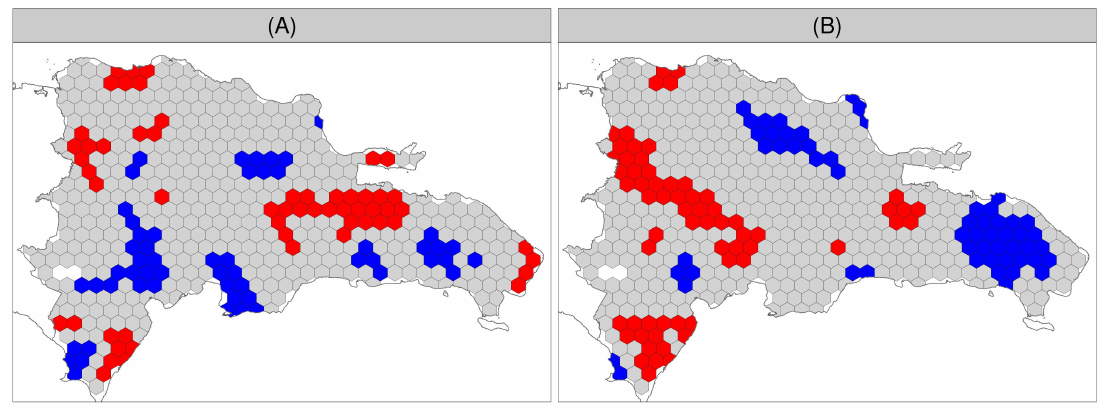
Figure 5 – LISA maps (local indicators of spatial association maps) of (A) forest loss per unit area averaged per year for the period 2001-2018, and (B) fire points per km 2 averaged per year within forest cover for the same periods using the MODIS dataset. The Tukey’s Ladder of Powers transformed versions of the variables were used as inputs in all cases. Each hexagon was classified either as HH cluster—group of cells in which high values are surrounded by other high values—(depicted in red), LL cluster—cells with low values surrounded by other low values—(depicted in blue), or no significant spatial association (grey) regarding the corresponding variable.